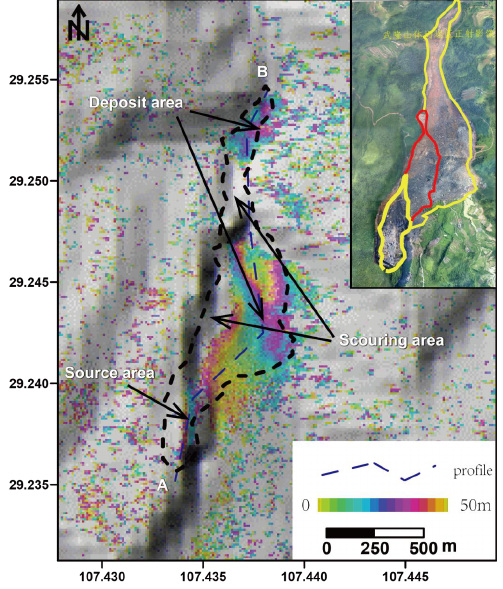
Fig. 9. DEM change map calculated by InSAR stacking method after Jiweishan sliding. The black dashed line delineates the affected region based on an aerial photo and the blue dashed line represents the location of the profile AB shown in Fig. 10.